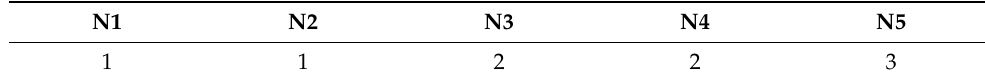
Table 11. Number of branch nodes used.